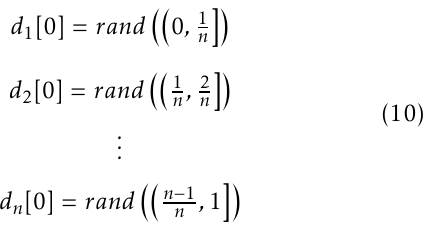
Figure 5. Particle swarm convergence for three particles, q and q . The arrows sizes are proportional to the particles speeds 2 and the graphs show the paths from (a) 1st to 2 nd , (b) 2 nd to 3 rd , and (c) 3 rd to 4 th